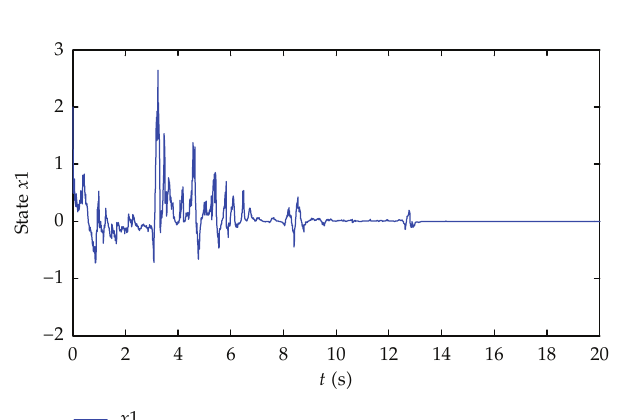
Figure 2: State x 1 of the closed-loop system.